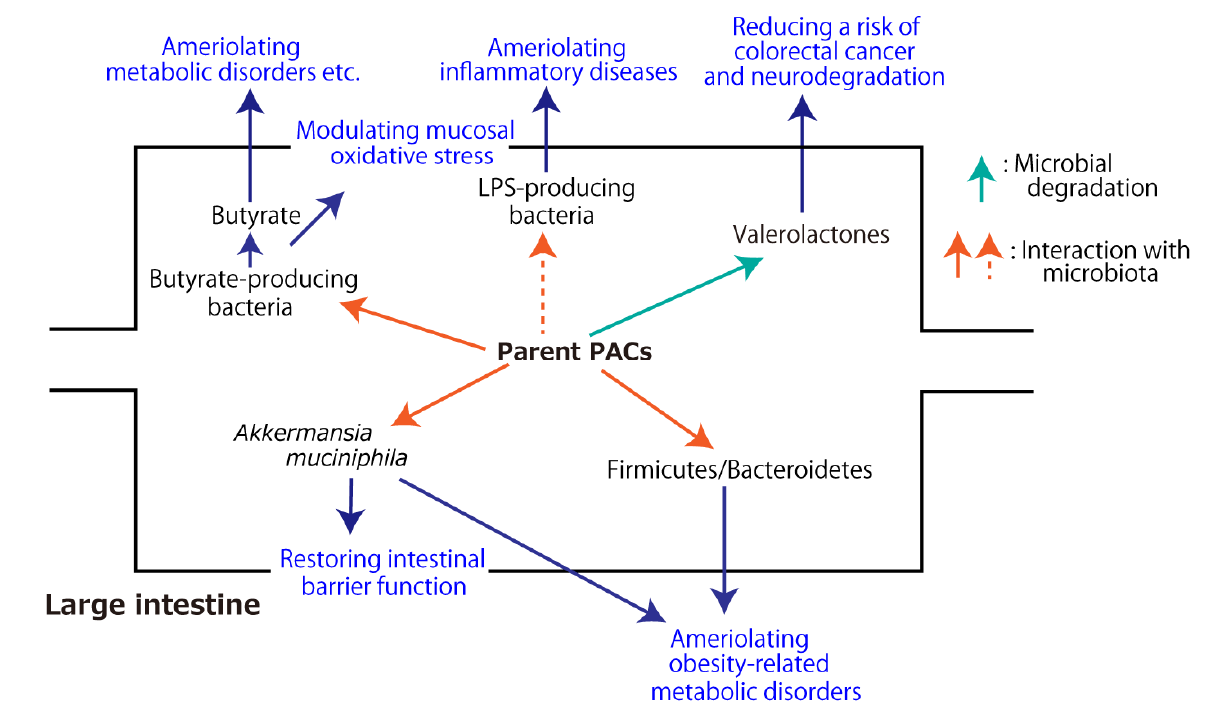
Figure 3. Health-beneficial effects of proanthocyanidins (PACs) associated with gut microbiota. The dashed arrow indicates the inhibitory effect.